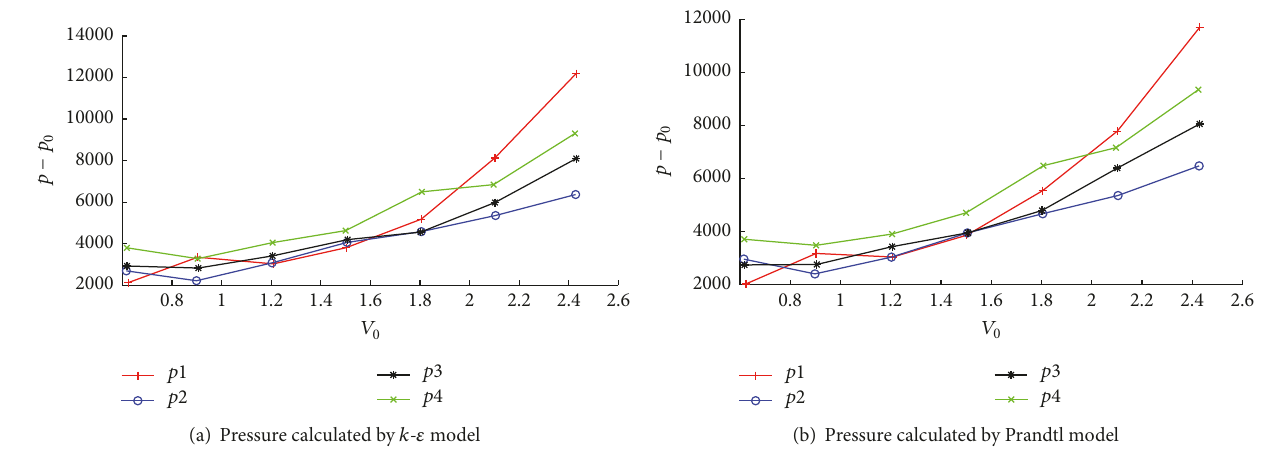
Figure 16: Oblique water entry with angle 9.8 ∘ .